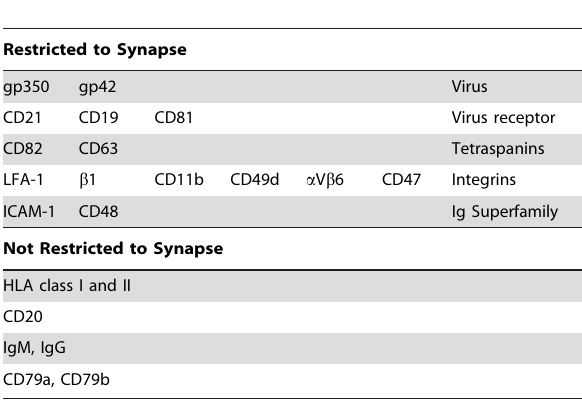
Table 1. B cell surface molecules capped following EBV infection and present within the B cell-epithelial cell synapse.